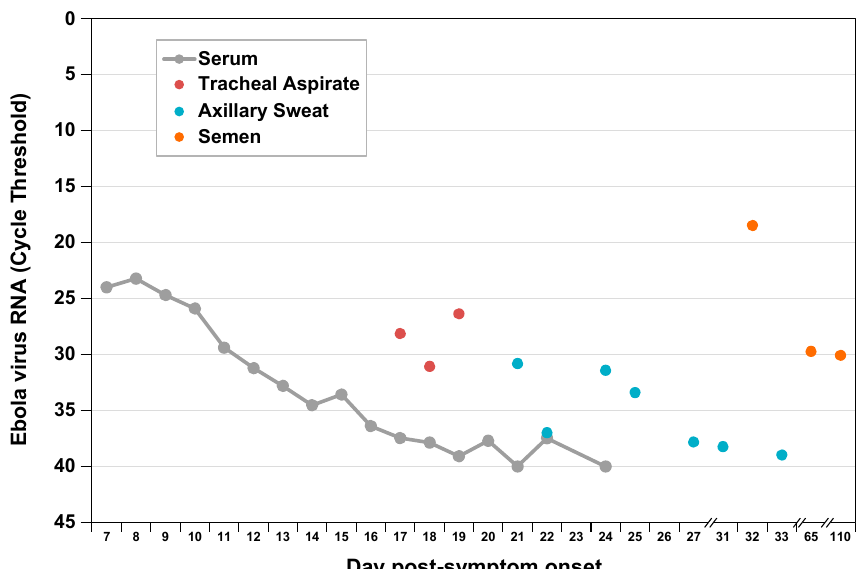
Figure 1. Ebola virus RNA levels by compartment during acute and convalescent illness. We measured viral RNA extracted from multiple sample types by EZ-1 quantitative reverse-transcription polymerase chain reaction assay as previously described [6]. Previously published serum and semen data are included for comparison [5,6].